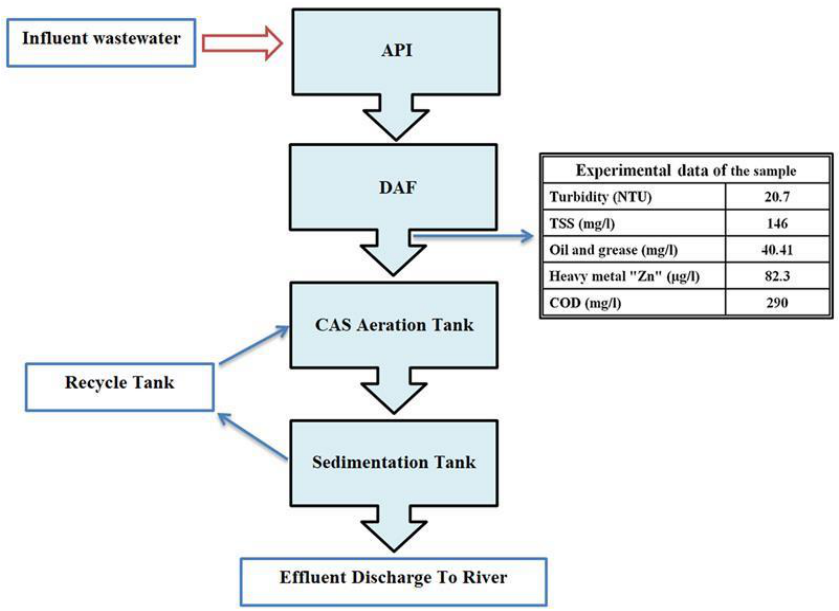
Figure 1. Diagram of petroleum wastewater treatment in Al-Daura refinery.